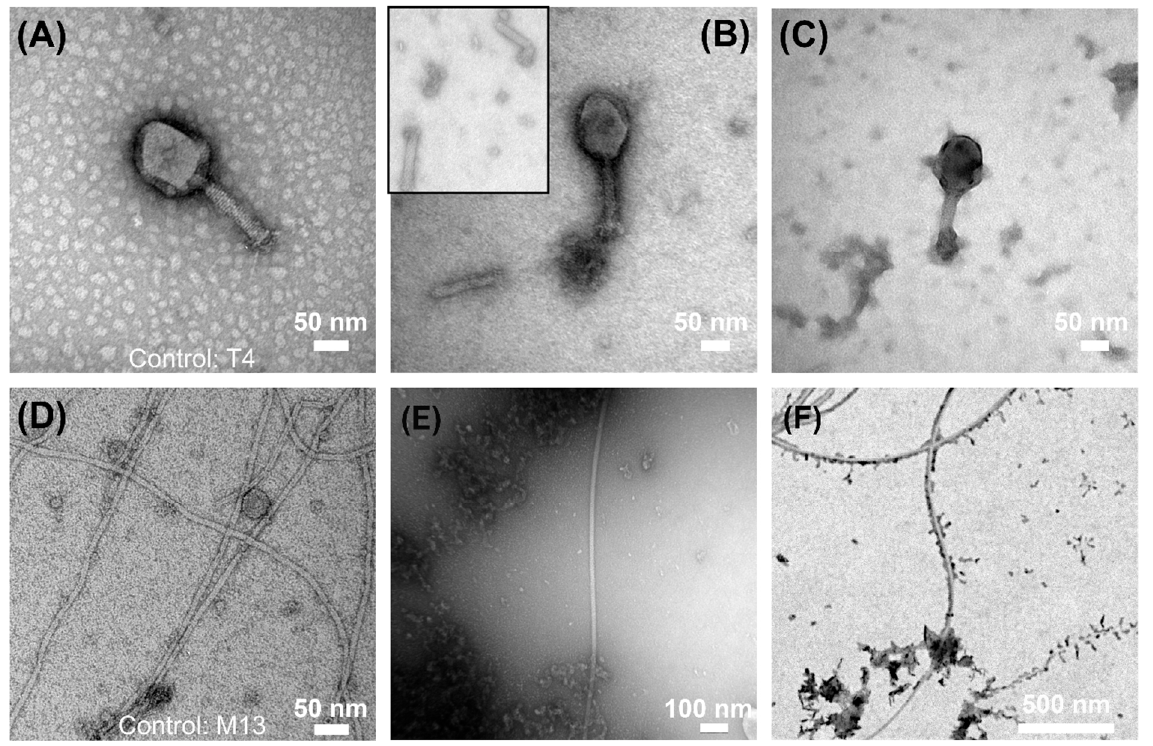
Figure 4. TEM visualization of bacteriophages. ( A ) T4 bacteriophages in the absence of zero-valent iron. ( B , C ) T4 bacteriophages exposed to O ZVI. Inset in ( B ) shows the detached tails, which were in abundance in the sample. ( D ) M13 bacteriophages in the absence of zero-valent iron, ( E ) Supernatant of the suspension containing only a small number of M13 virions, among which majority were in contact with nZVI particles. ( F ) STEM image of the freshly agitated suspension wherein nZVI and M13 appeared in close proximity.